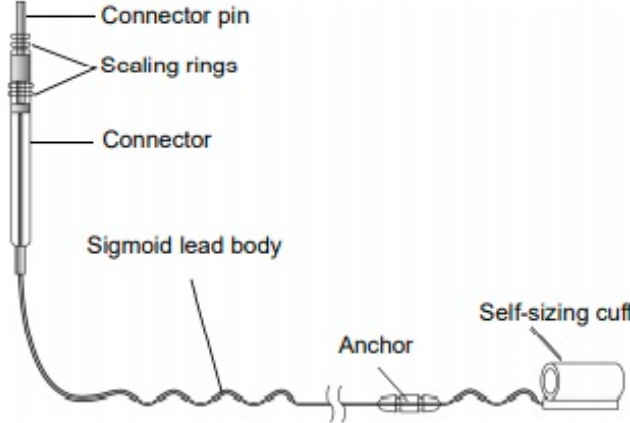
Figure 6. The Inspire stimulation lead.